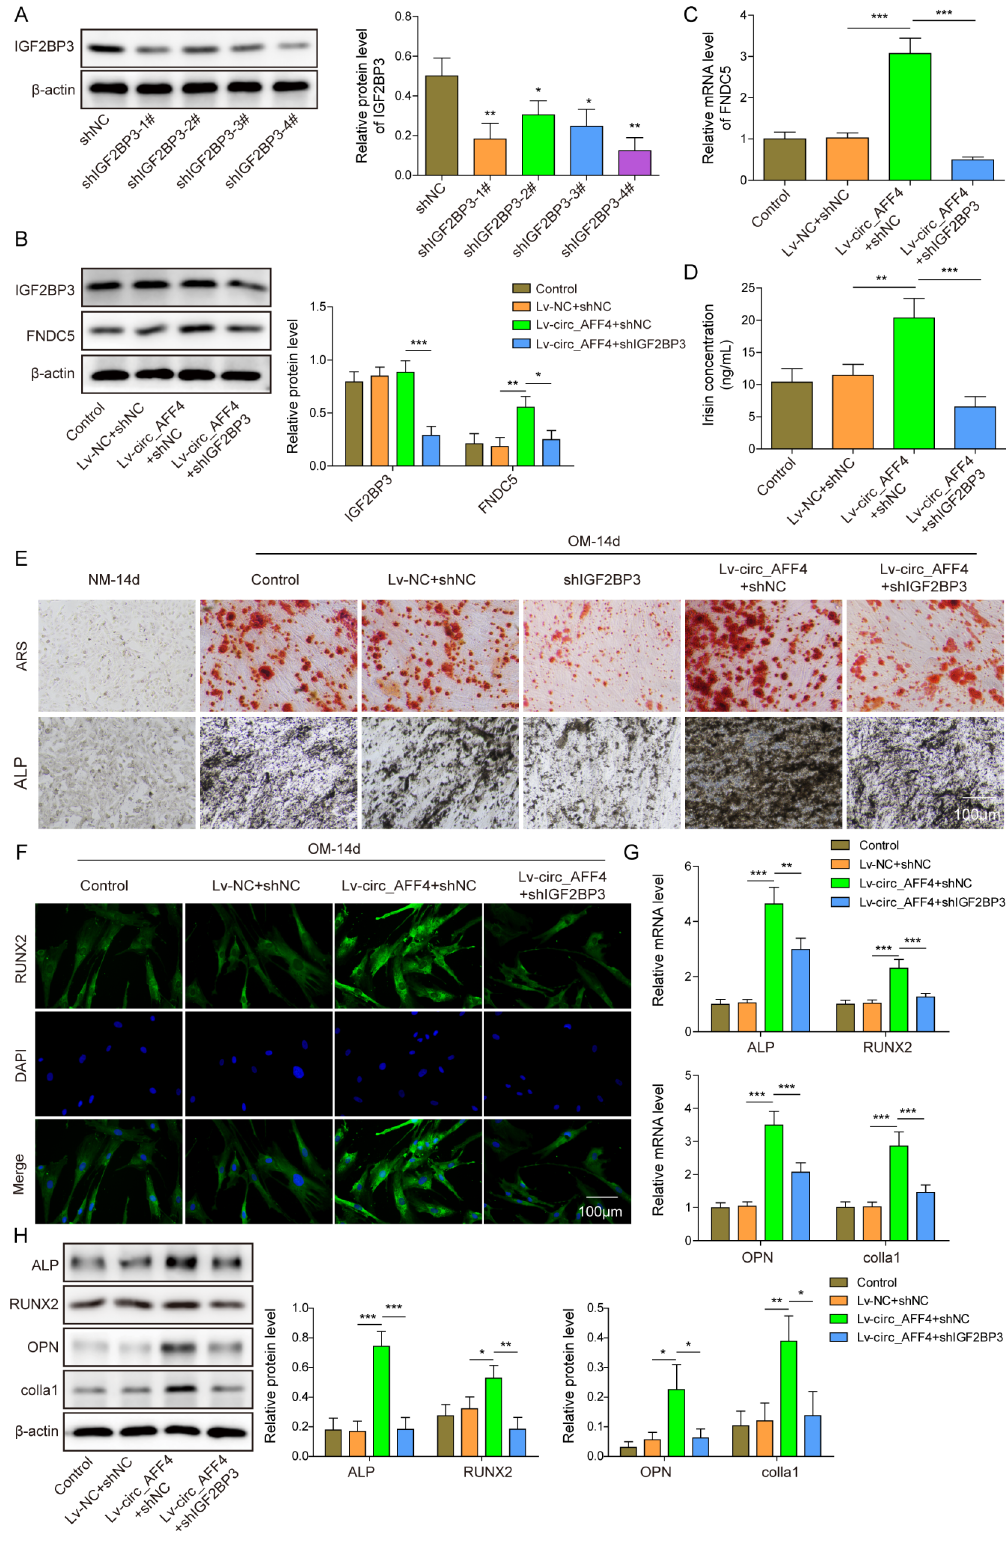
Fig. 4 Promotion of circ_AFF4 on osteogenic differentiation via FNDC5/Irisin was counteracted by IGF2BP3 downregulation ( A ) BM-MSCs were transfected with shIGF2BP3_1–4# or shNC and the protein expression level of IGF2BP3 in shIGF2BP3_1–4# or shNC transfected BM-MSCs was detected using western blot. BM-MSCs that transfected with lentivirus-circ_AFF4 (lv-circ_AFF4) and shNC or shIGF2BP3 and lv-circ_AFF4 or shNC and lentivirus-NC (lv-NC) were cultured in OM or NM for 14 days. Gene and protein expression of IGF2BP3 and FDNC5/Irisin were assessed by western blot ( B ), RT-qPCR ( C ) and ELISA( D ). Afterward, different assays were performed to assess the osteogenic differentiation. ( E ) Representative images of ARS and ALP staining. Scar bar = 100 μm. ( F ) Representative RUNX2 immunofluorescence staining image. Scar bar = 100 μm. Gene and protein expres- sion of osteogenic markers, ALP, OPN, RUNX2 and Colla1, were detected by ( G ) RT-qPCR and ( H ) western blot. * p < 0.05, ** p < 0.001 and *** p < 0.001. Each experiment was performed at least three times